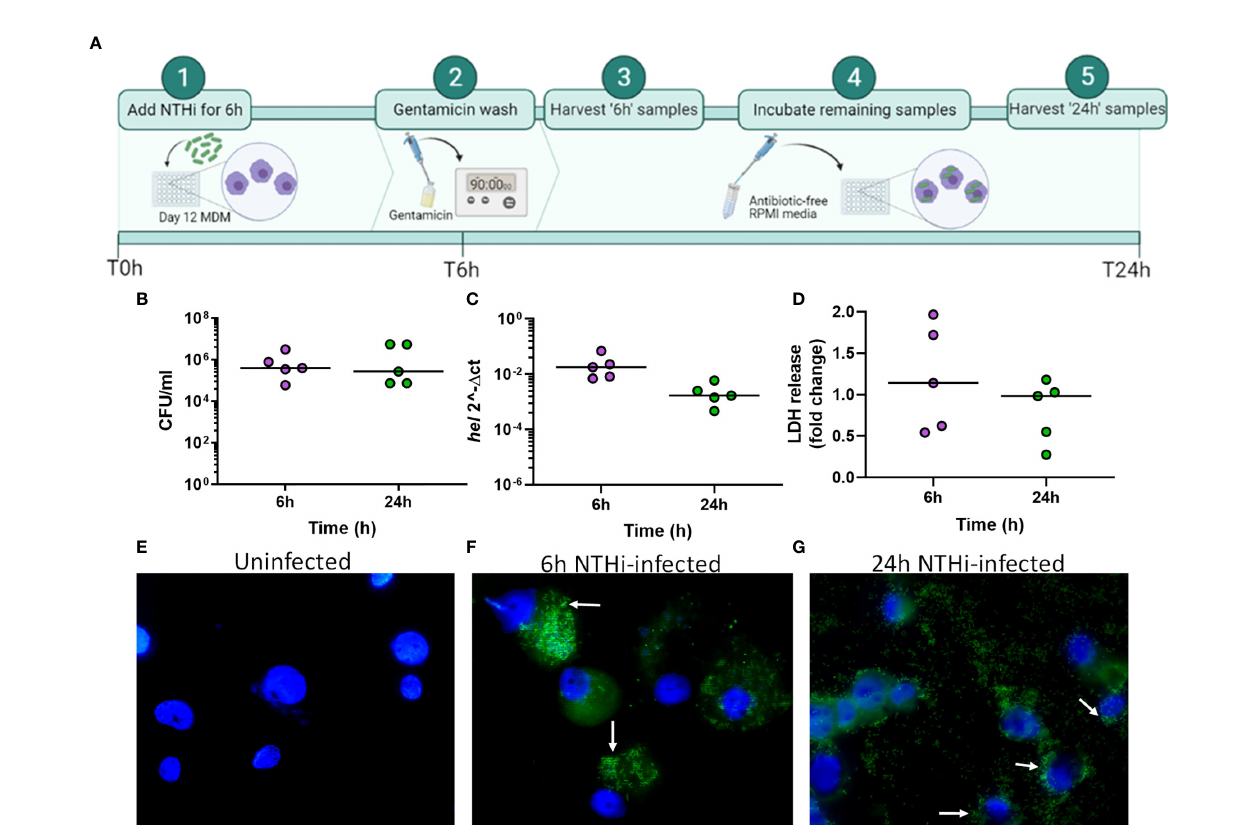
FIGURE 1 | Modelling NTHi infection of macrophages. (A) Model work fl ow: MDM were challenged with NTHi for 6 h, washed with gentamicin for 90 min to remove extracellular NTHi and left to incubate in antibiotic-free media until 24 h (created using BioRender.com). (B) The 6 h and 24 h time point MDM samples were lysed and plated to quantify the amount of NTHi associated with MDM. (C) RNA was harvested from the 6 h and 24 h uninfected and NTHi-infected MDM samples to assess the presence of NTHi RNA through detection of the hel gene by qPCR. Expression of the hel gene was normalised to B2M . (D) MDM viability was not impacted by NTHi ST14 infection, as assessed by LDH release into cell culture supernatants at 6 h and 24 h. (B – D) (n = 5) show paired data and lines indicate medians. Data were analysed by Wilcoxon signed-rank test and no statistical signi fi cance was determined. GFP-NTHi was used to visually con fi rm NTHi association with MDM at the 6 h and 24 h time points. Uninfected and NTHi-infected MDM were streaked and fi xed onto glass sides followed by staining with DAPI. Slides were visualised using the AxioScope KS400 fl uorescence microscope at 100x magni fi cation. (E) Uninfected MDM, (F) GFP-NTHi infected MDM at the 6 h time point and (G) GFP-NTHi infected MDM at the 24 h time point. White arrows indicate NTHi associated with MDM cell